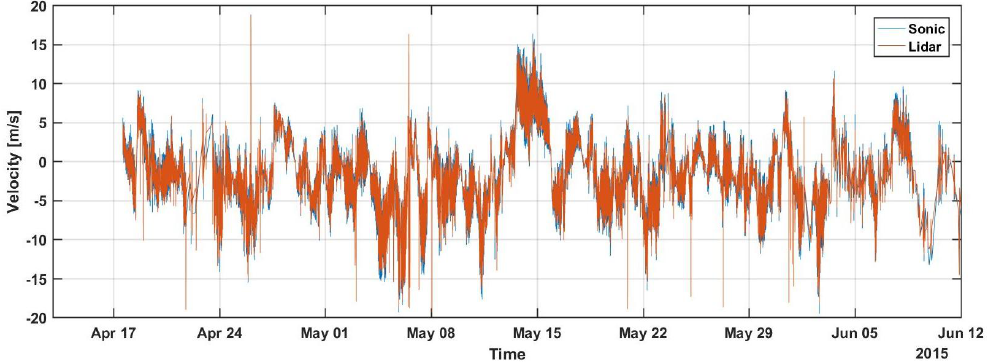
Figure 8. Time series of one-dimensional 1 Hz velocities from 13 April 2015–11 June 2015 measured with the Lidar and the sonic anemometer. Times are local (UTC + 1:00).